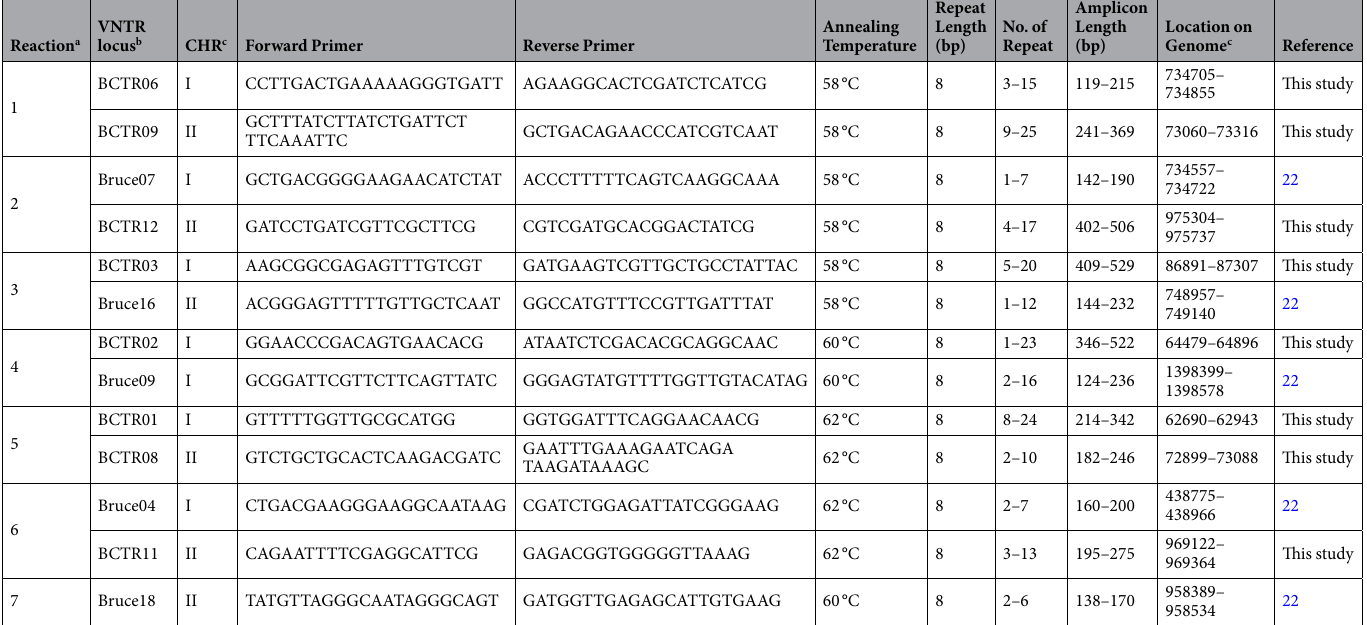
Table 2. Primer and VNTR loci information for the MLVA-13Bc genotyping method developed in this study. a The primers were grouped into 6 duplex PCR reactions plus a singular PCR reaction. b VNTR: Variable number tandem repeat. c Chromosome number to which the VNTR loci are located on the genome of B . canis